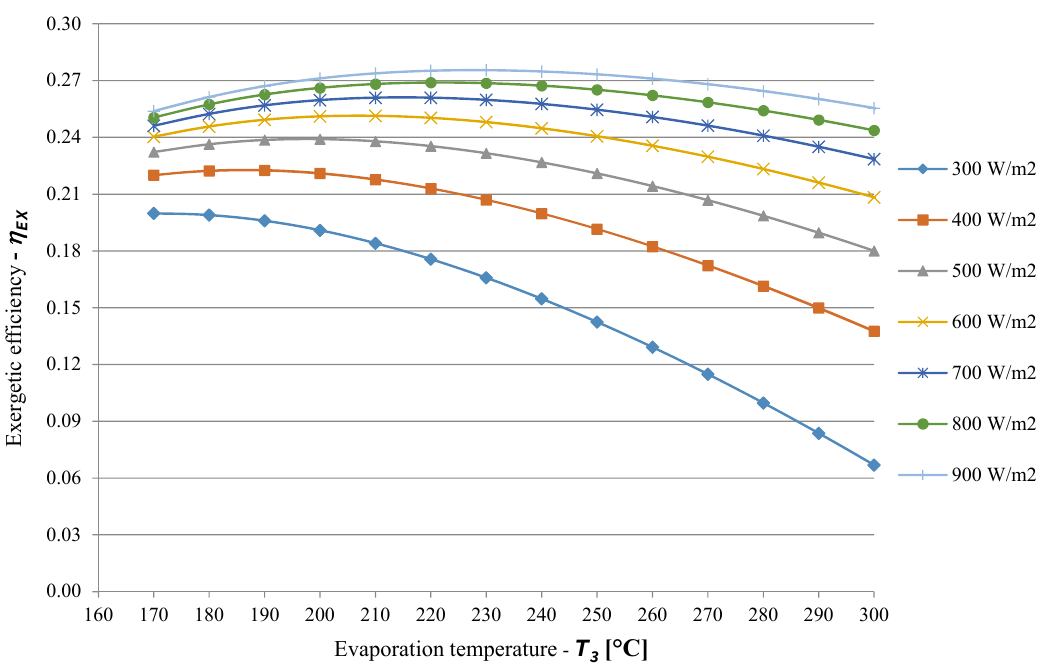
Figure 7. Exergetic efficiency versus vaporization temperature under growing solar radiation when the condensation pressure is fixed at 0.4 bar.